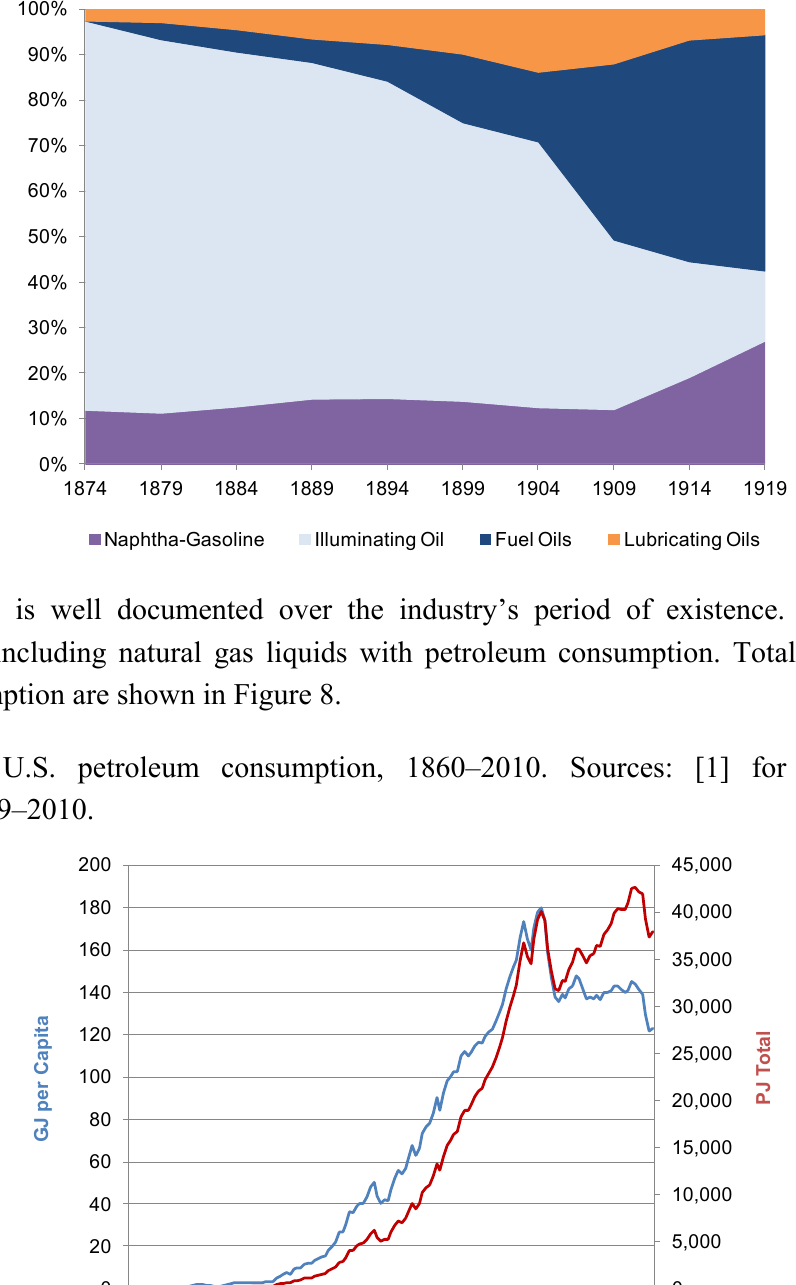
Figure 7. Shares of U.S. oil refinery output, 1874–1919. Sources: [61–63].